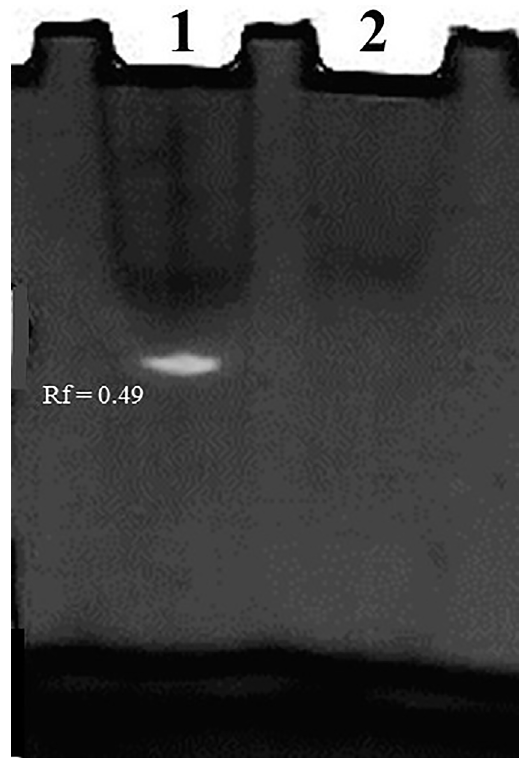
Fig. 4 . Zymogram of acid proteases from enzyme stomach extracts of Archosargus probatocephalus. Crude enzymatic extract (1), crude enzymatic extract plus Pepstatin A